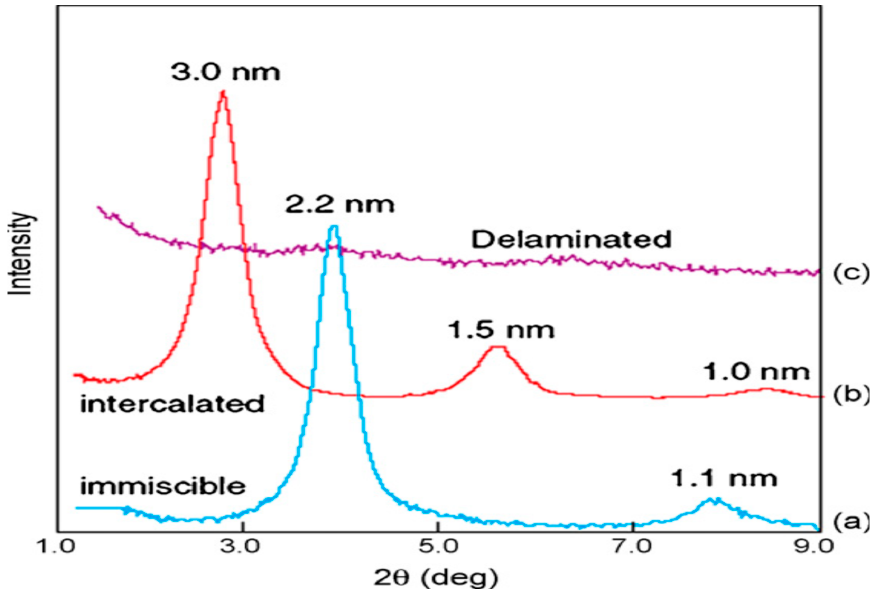
Figure 10. WXRD patterns for polymer/layered silicates: ( a ) polyethylene + organoclay → phase- separated composites; ( b ) polystyrene + nanoclay → intercalated composite; ( c ) siloxane + nanoclay → exfoliated composite [43].